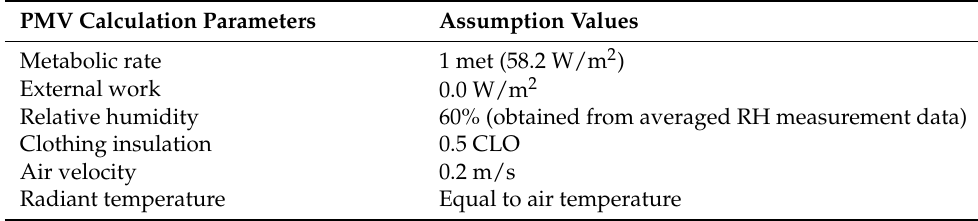
Table 4. PMV calculation parameters and assumption values.